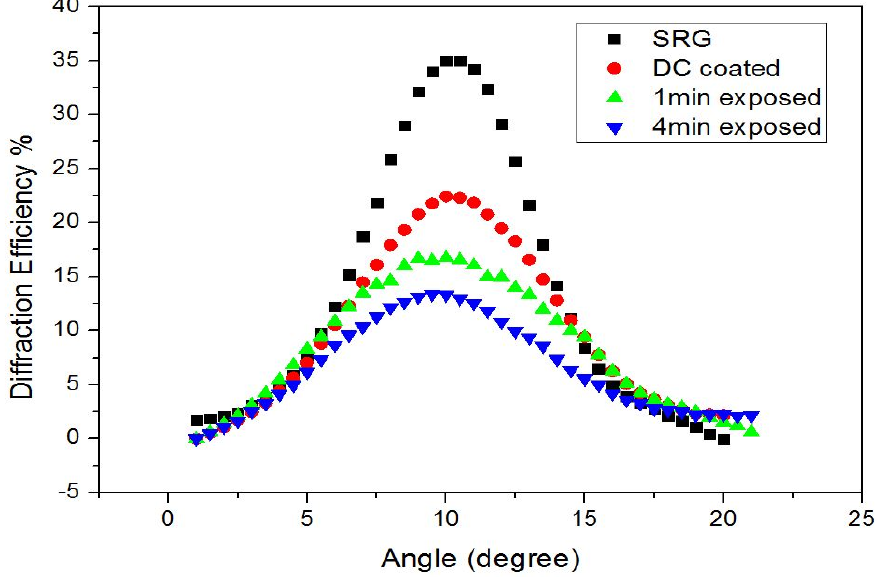
Figure 7. Bragg curves for SRG ( Figure 7. Bragg curves for SRG ( ), after spin coating with (DC) / PVC layer ( ) and after exposure ), after spin coating with (DC)/PVC layer ( Figure 7. Bragg curves for SRG ( ), after spin coating with (DC) / PVC layer and after exposure ) and after exposure to Figure 7. Bragg curves for SRG ( ), after spin coating with (DC) / PVC layer ( ) and after exposure Figure 7. Bragg curves for SRG ( ), after spin coating with (DC) / PVC layer ( ) and after exposure Figure 7. Bragg curves for SRG ( ), after spin coating with (DC) / PVC layer ( ) and after exposure to analyte K + (50 mM) ( , ). analyte K + (50 mM) ( , to analyte K + (50 mM) ( , ). to analyte K + (50 mM) ( , ). to analyte K + (50 mM) ( , ). to analyte K + (50 mM) ( , ).